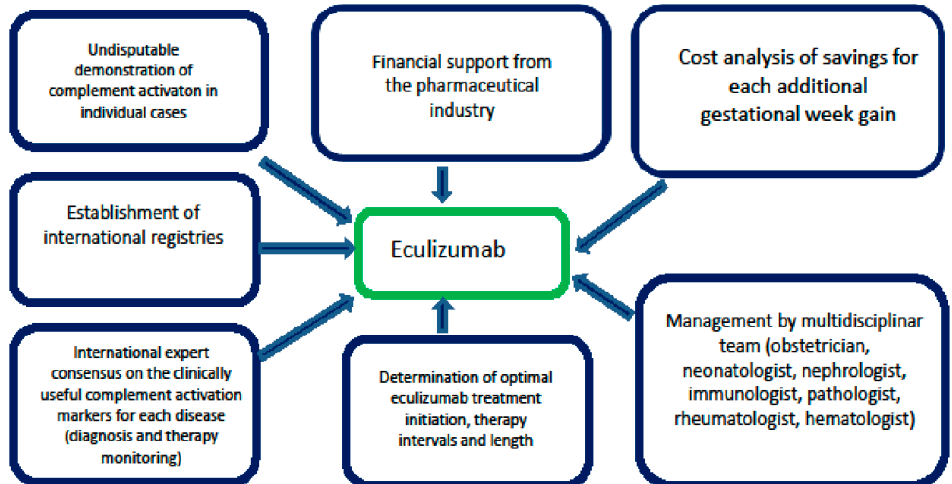
Figure 2. Essential steps before potential extended use of eculizumab in complement-associated diseases in